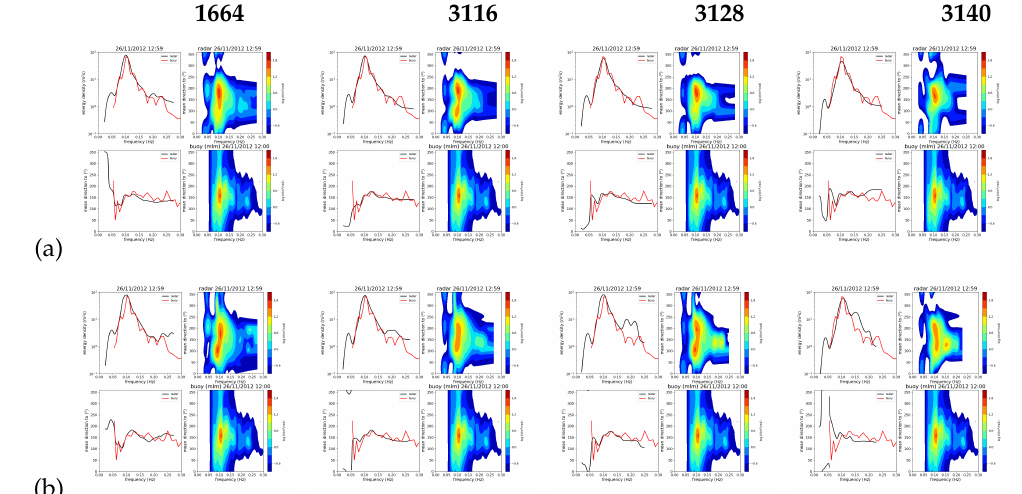
Figure 21. Inverted spectra for case 6. ( a ) monostatic ( b ) 1 bistatic.